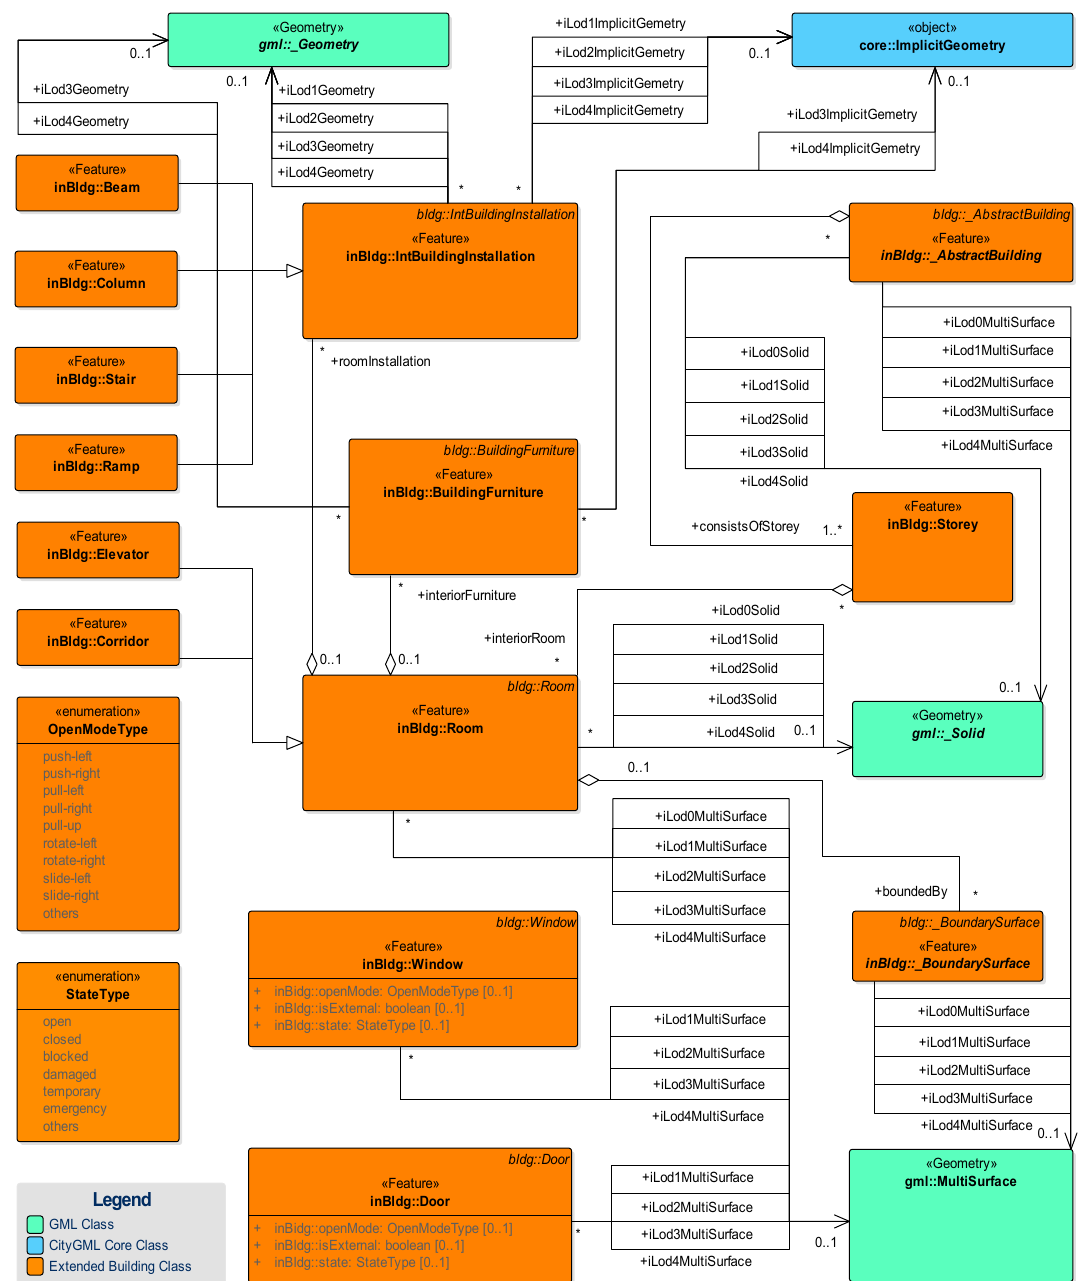
Figure 9. CityGML ADE mechanism for the interior of the building model (for the full-color version, readers are referred to the electronic version of this paper).